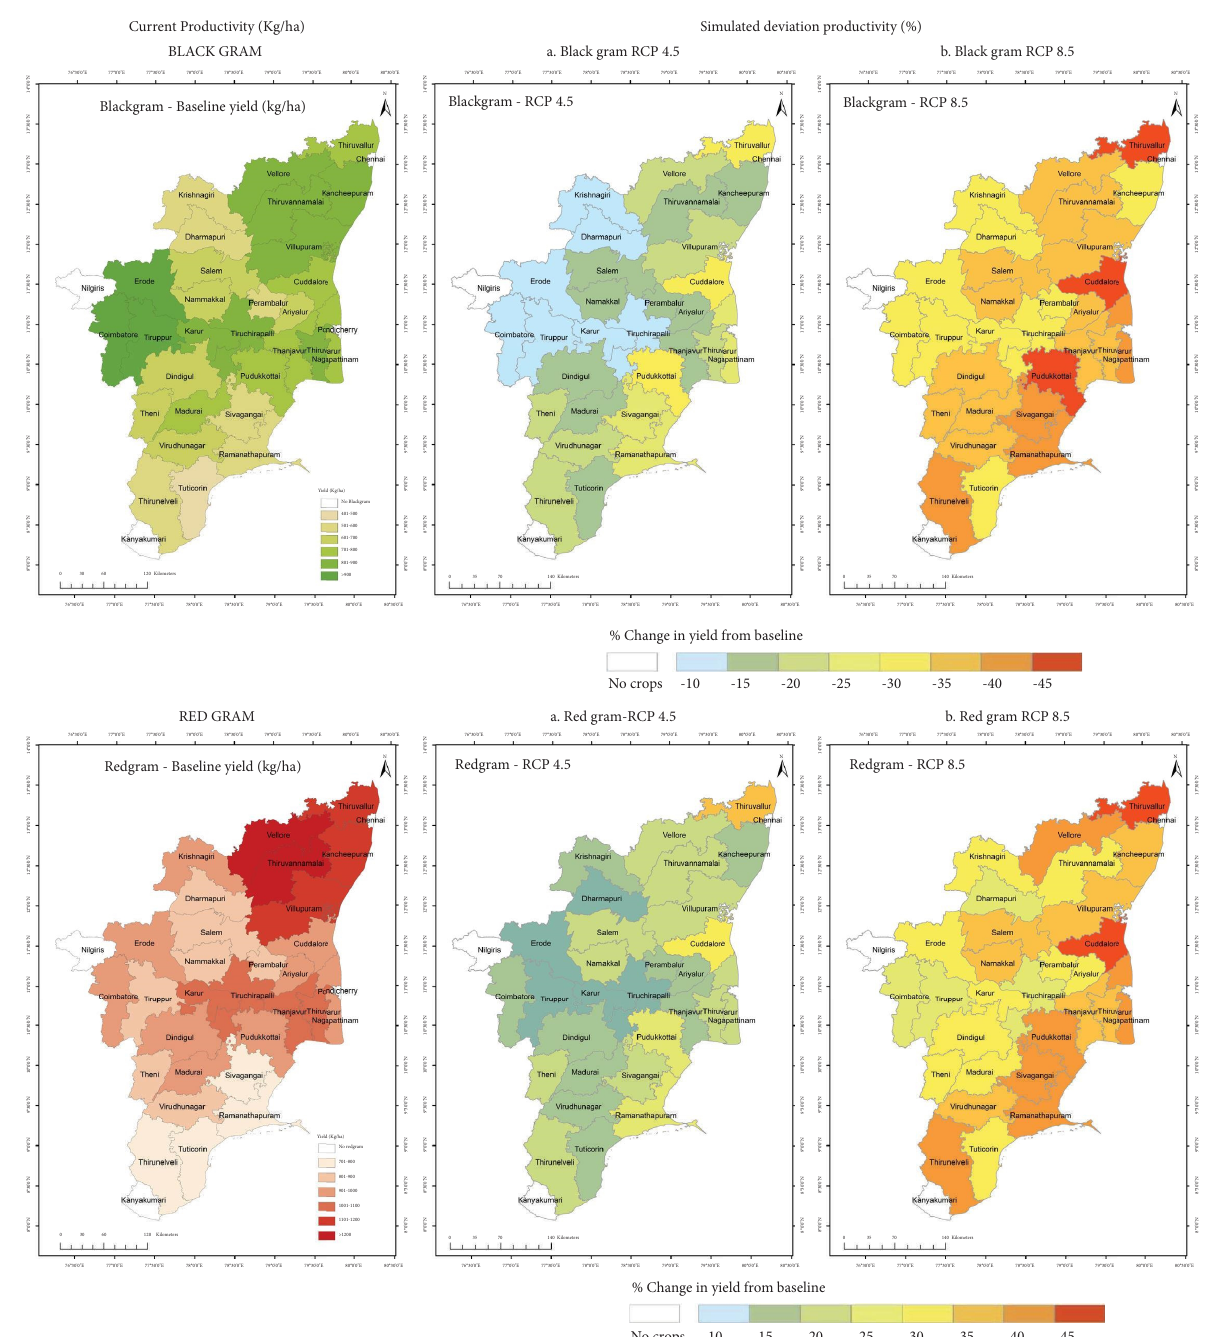
Figure 8: Spatial variability in black gram and red gram productivity under multi-model ensemble climate projection during current and future climate scenarios (RCP 4.5 and RCP